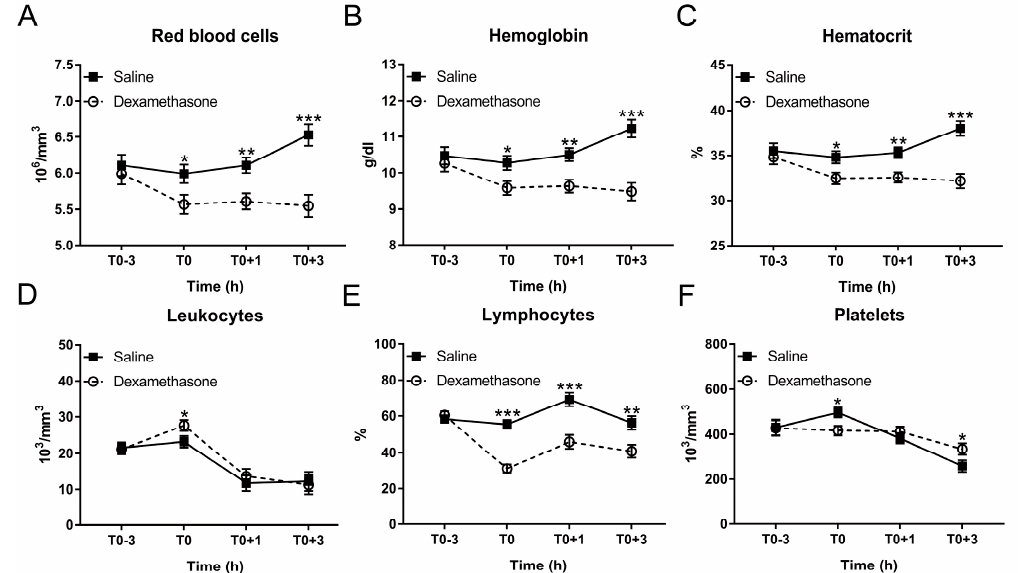
Figure 3. Effect of DEX on the kinetics of hematological parameters following LPS challenge. ( A ) Red blood cell count; ( B ) hemoglobin concentration; ( C ) hematocrit; ( D ) leukocyte count; and ( E ) lymphocyte proportion; (F) platelet count. Data are presented as least-squares means ± SE. * p < 0.05, ** p < 0.01, *** p < 0.001.